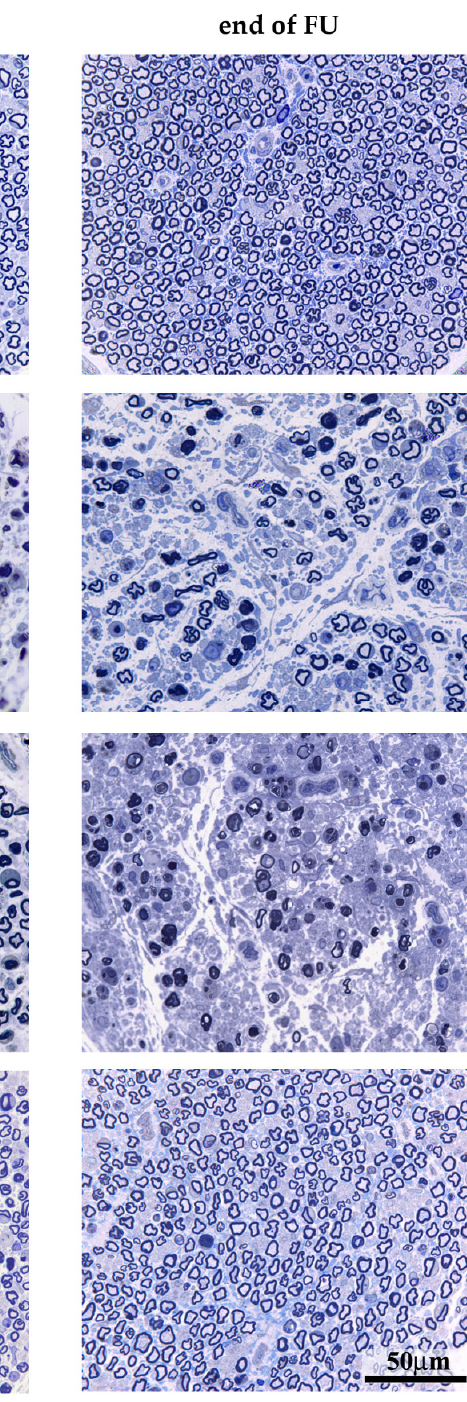
Figure 5. Morphological analysis of distal caudal nerves. IVIg co-treatment starting from the first PTX administration (PTX + IVIg4 group) reduced PTX-induced distal axonal degeneration.